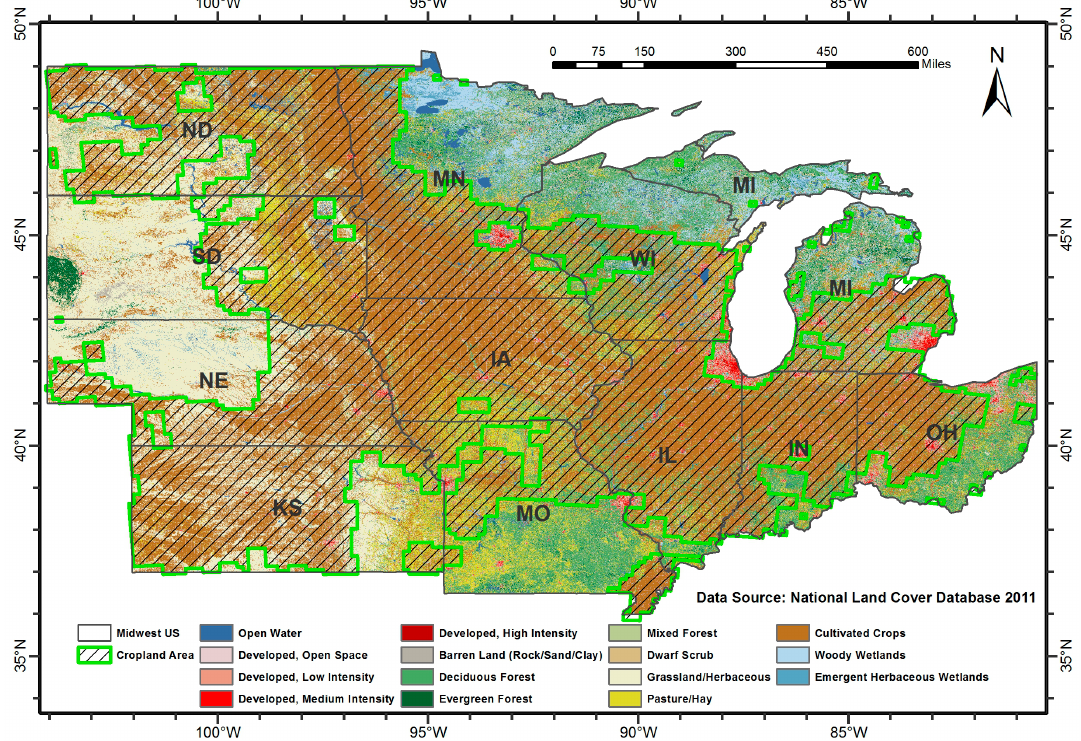
Figure 1. The study area of the cropland (lime green boundary) in Midwest US, which is consisted by 12 states, including North Dakota (ND), South Dakota (SD), Nebraska (NE), Kansas (KS), Minnesota (MN), Iowa (IA), Missouri (MO), Wisconsin (WI), Illinois (IL), Michigan (MI), Indiana (IN), and Ohio (OH).